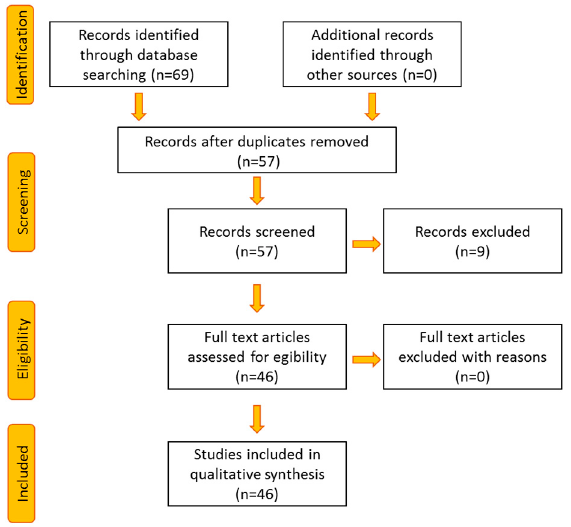
Figure 1. Literature screening procedure for the selection of papers included in the review.